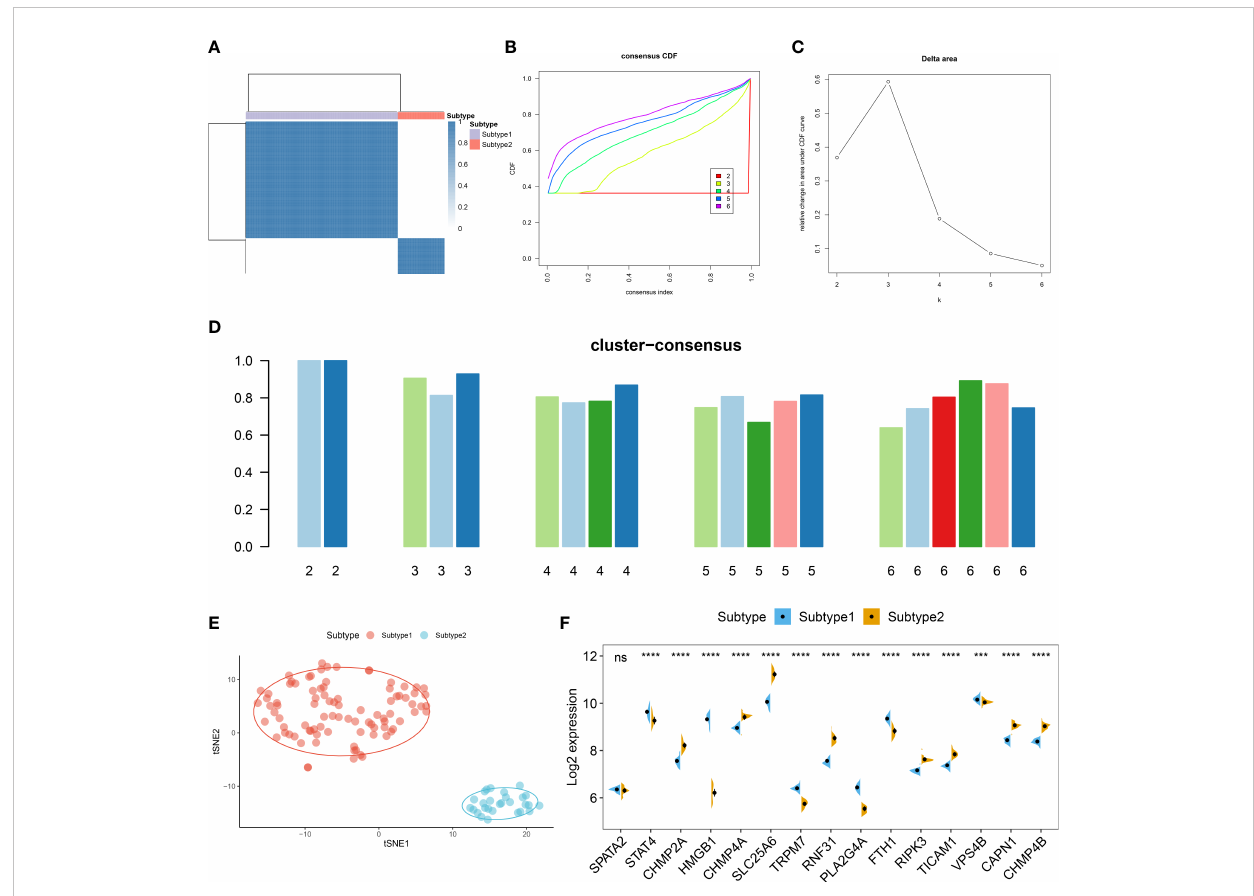
FIGURE 6 Identi fi cation of necroptosis subtypes in ASD. (A) Consensus clustering matrices in ASD children (k = 2) based on 15 differentially expressed NRGs. (B) Cumulative distribution function (CDF) curves when k = 2 – 6. (C) Relative alterations in the area under CDF curve. (D) Consensus clustering score of each subtype. (E) t-SNE demonstrating that ASD children are categorized into two distinct necroptosis subtypes. (F) Representative split violin plots revealing the expression of 15 differentially expressed NRGs between two